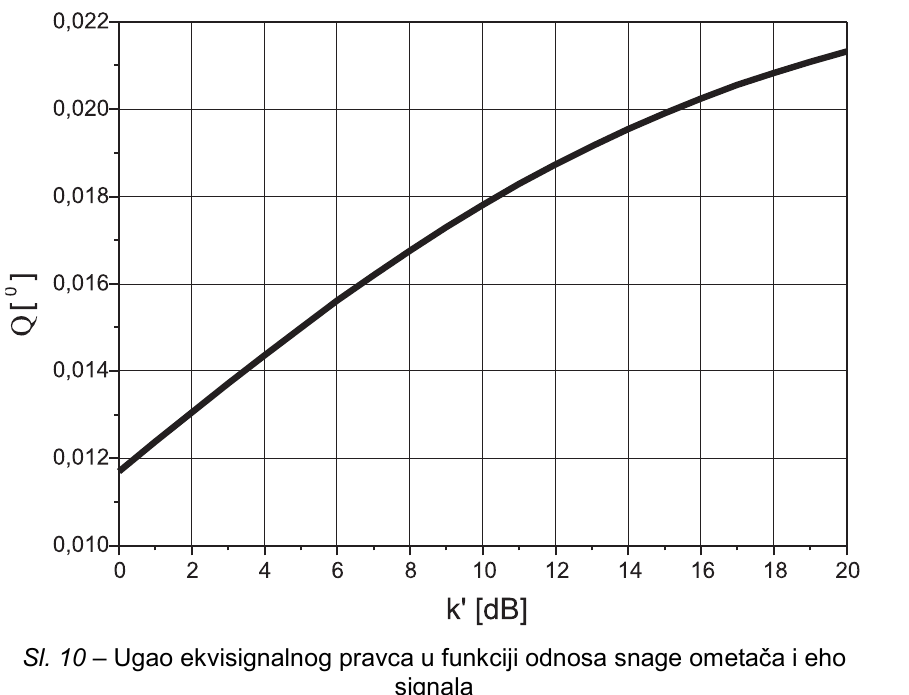
signala Zaklju č ak ostvaruje kada je fazna razlika izme đ u signala 180 0 . Pošto se ugao Δ Θ pod kojim se vide antene ometa č a može aproksimirati sa d/r (u radijanima), dolazi se do zaklju č ka da je greška proporcionalna rastojanju izme đ u antena ometa- č a (d), a inverzno proporcionalna rastojanju izme đ u radara i letelice koja vrši protivelektronsko dejstvo (r). Kako je greška koja je uneta pri ometanju sra- zmerna uglu Δ Θ (izraz 30), to zna č i da je poželjno da antene koje se koriste za ometanje budu na najve ć em mogu ć em rastojanju dokle god su obe antene unutar glavnog loba dijagrama zra č enja antene radara koji se ometa. Zato se naj č eš ć e postavljaju na krajevima krila letelice. Zbog toga efikasnost ometanja raste sa smanjenjem rastojanja izme đ u ometa č a, što je suprotno od onoga što bi se o č ekivalo u sukobu radara i ure đ aja za ometanje. Za fiksno